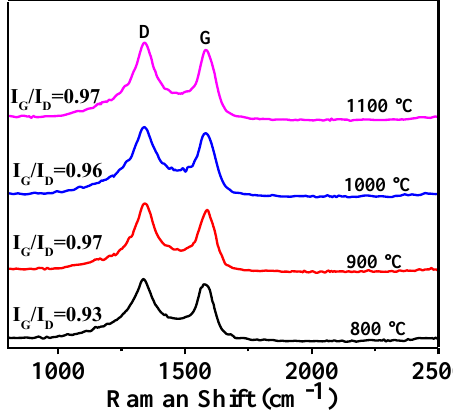
Figure 2. Raman spectra of HGCS whose XRD patterns are given in Figure 1.